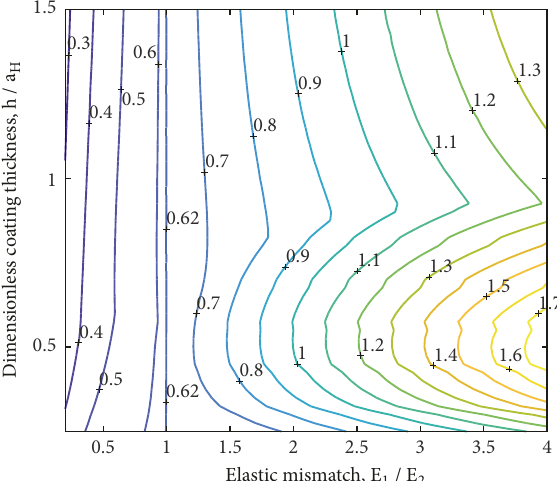
Figure 14: Iso-contours of dimensionless maximum von Mises equivalent stress 𝜎 ( max ) 𝑉𝑀 /𝑝 𝐻